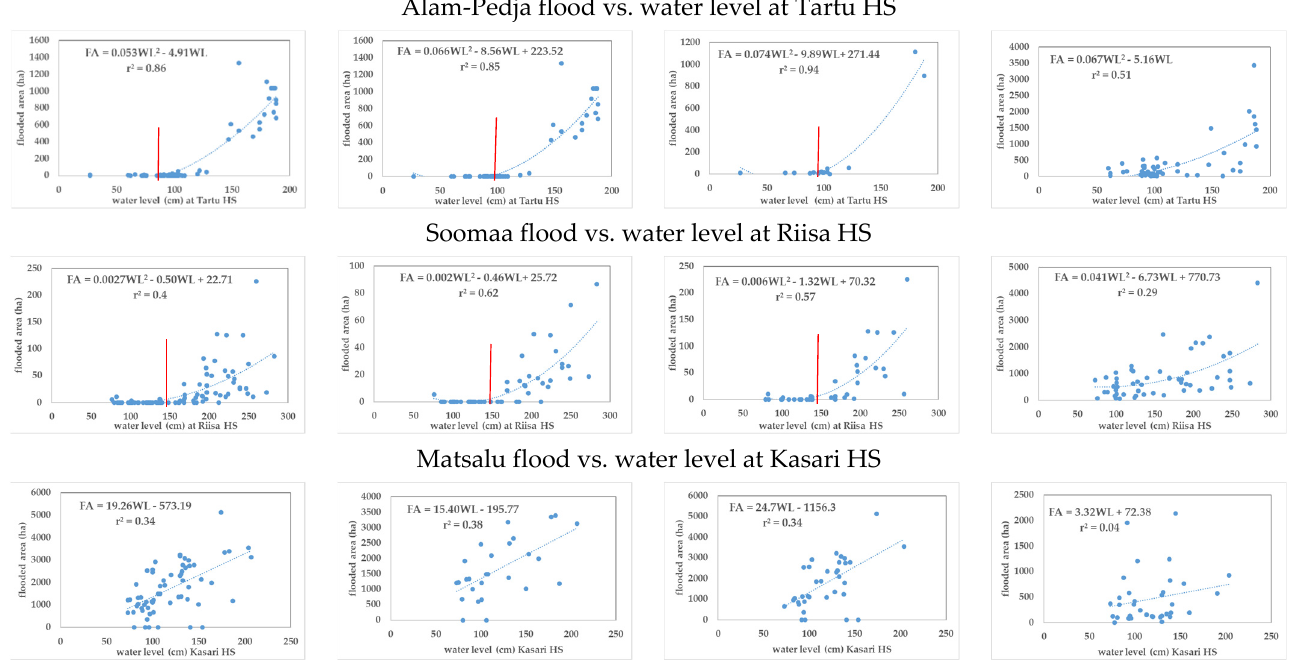
Figure 7. Correlation between flooded area and water level at the closest hydrological station. FA: flooded area extent; WL: water level. Red line denotes the critical water level at which coastline excess occurs and flooding starts.